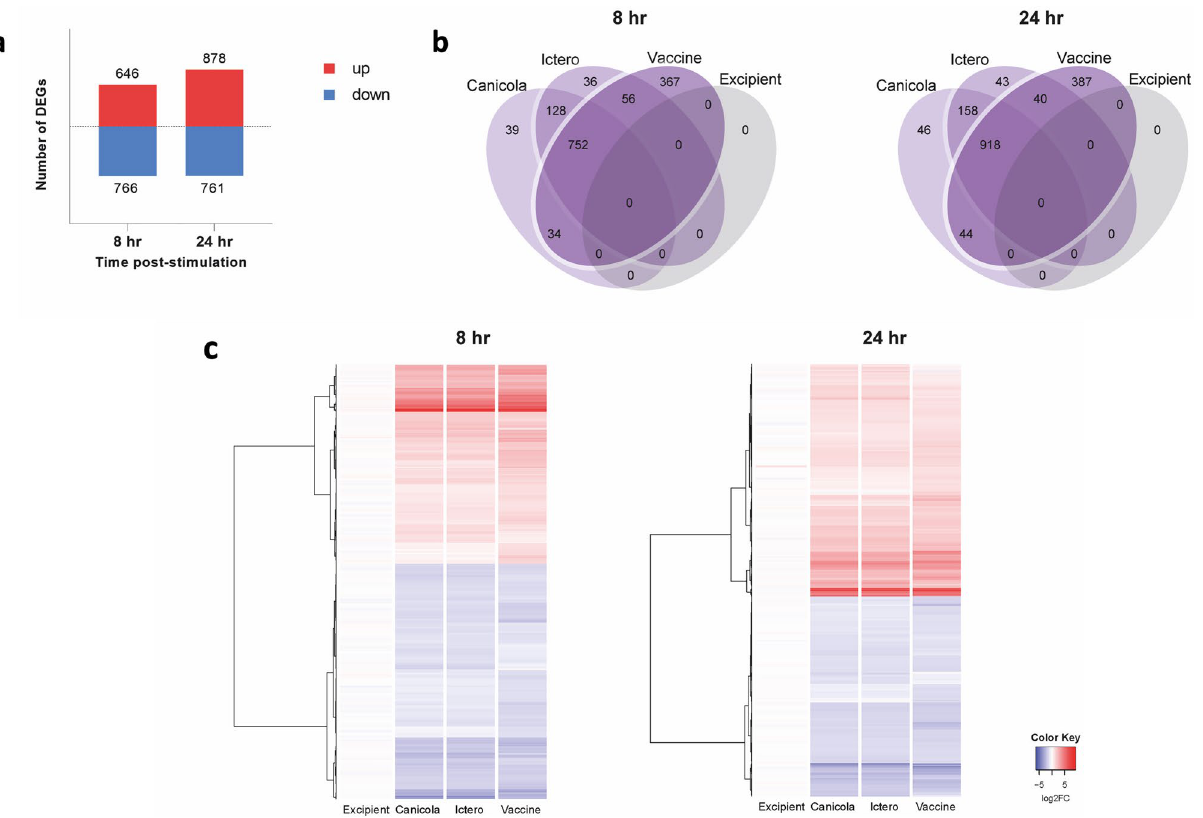
Figure 1. DEGs (FC ≥ 2; P < 0.001, FDR 5%) found in canine 030-D cells after 8 and 24 h stimulation with the inactivated L. interrogans serogroup Canicola or Icterohaemorrhagiae or bivalent Leptospira vaccine B. ( a ) The number (y-axis) and directionality (upregulated = positive y-space, downregulated = negative y-space) of DEGs after stimulation with the inactivated L. interrogans serogroup Canicola or Icterohaemorrhagiae, bivalent Leptospira vaccine containing the same Leptospira strains or vaccine excipient as non-antigen control (all manufacturer B). ( b ) Venn diagram of DEGs shown in ( a ). ( c ) Heatmap representing hierarchical clustering of DEGs for all stimuli. The color key represents the changes (log2 scale), from most downregulated (dark blue) to most upregulated genes (red). Each row is a gene, and each column is a stimulus (average of n = 3